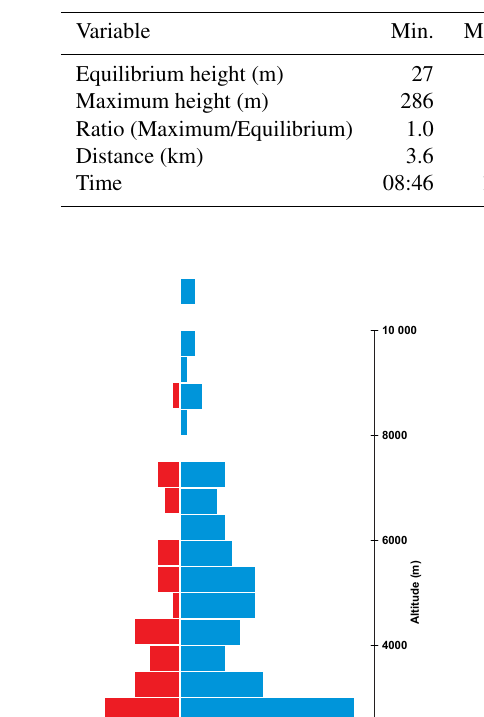
Table 2. A summary of plume observation statistics.